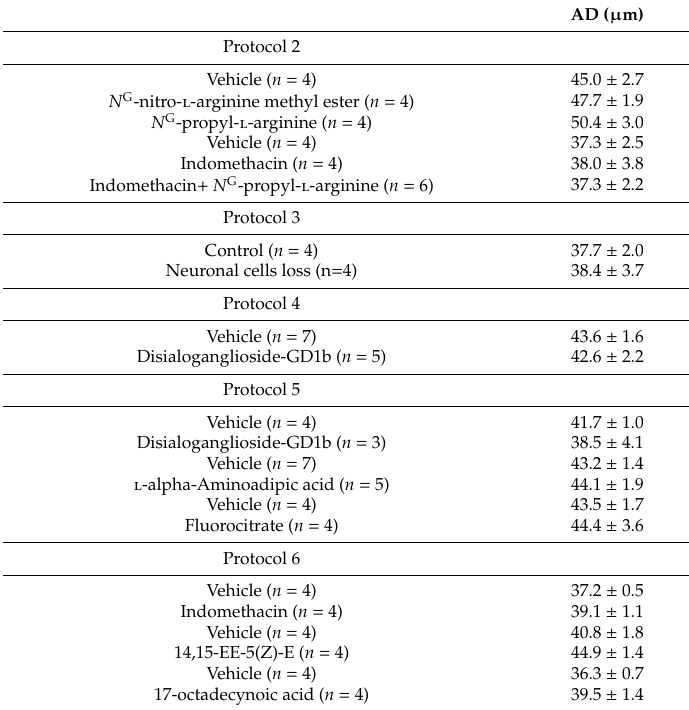
Table 2. Baseline values of retinal arteriolar diameter in each experimental